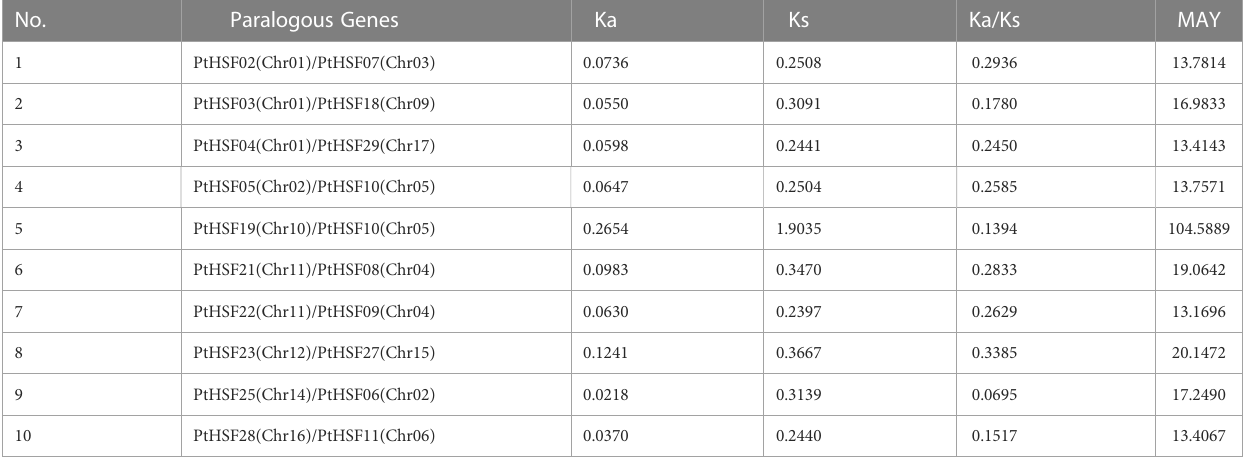
Ka indicates non-synonymous substitution rate. Ks indicates synonymous substitution rate. MYA indicates million years ago.